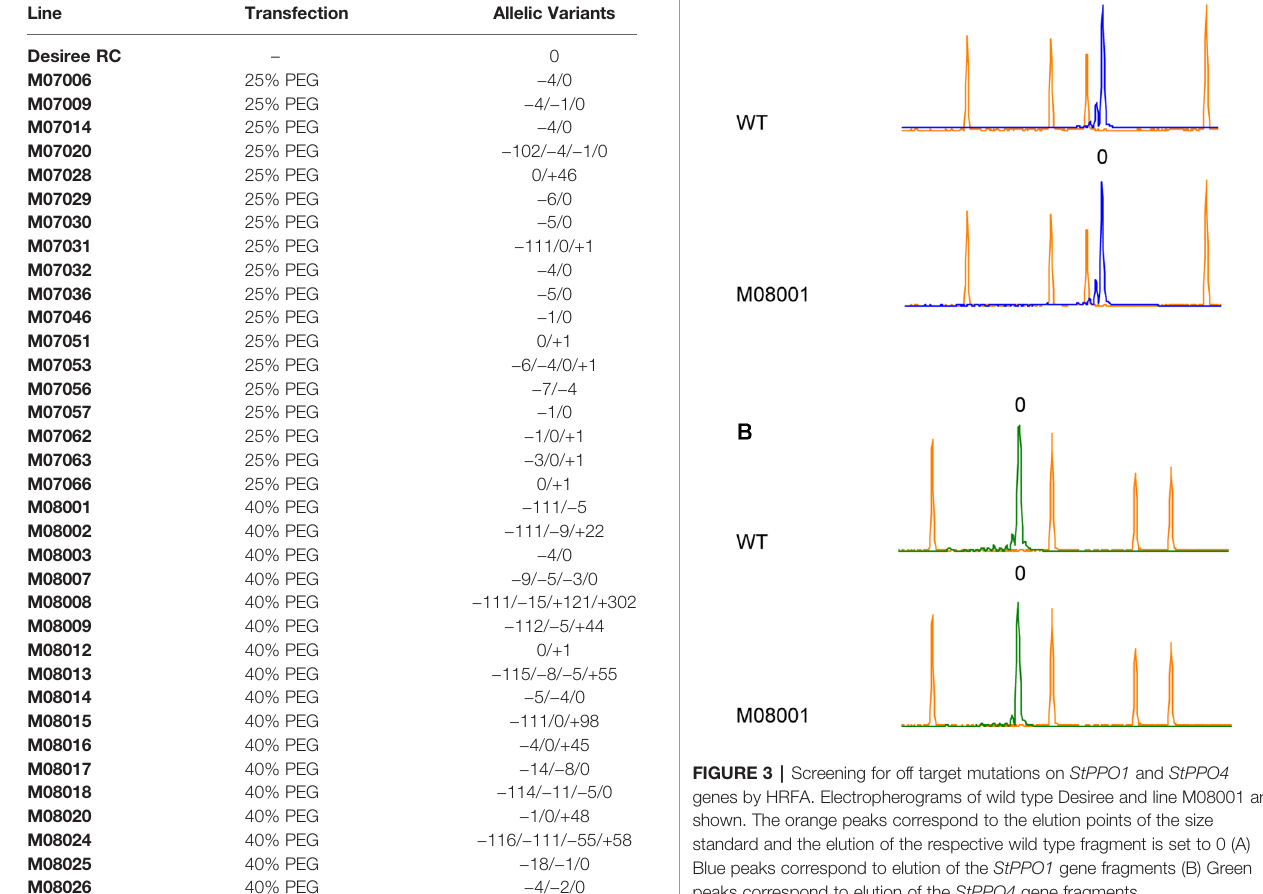
TABLE 1 | Edited lines per experiment detected by HRFA.